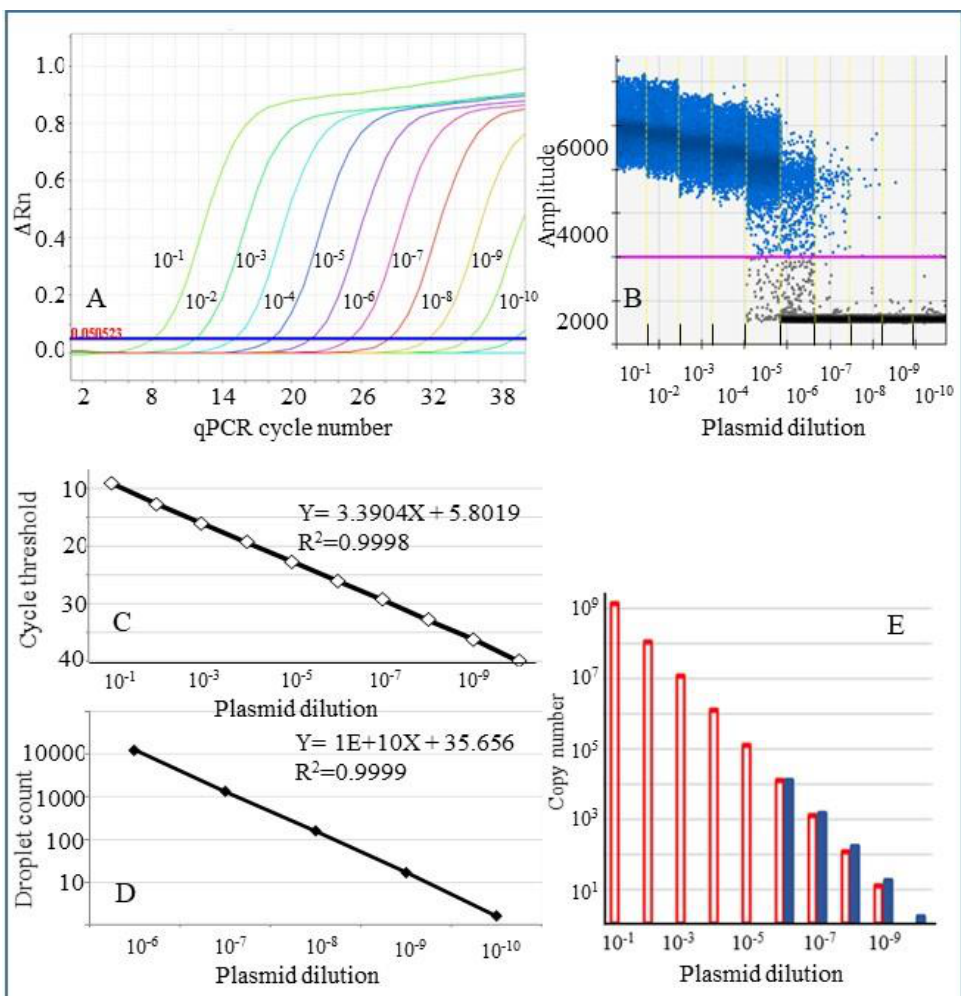
Figure 3. Linear regression analysis of qPCR and ddPCR conducted using ten-fold serial dilutions of a plasmid preparation containing CLas 16S rDNA fragment. ( A ). Amplification plots of plasmid serial dilutions in qPCR. ΔRn is the normalized reporter value (Rn) minus the Rn value of the baseline signal. Cycle threshold values are indicated on X-axis. The plasmid dilutions are shown to the left of each amplification graph. ( B ). ddPCR results of the plasmid dilutions used in qPCR. About 14,000 – 16,000 droplets passed QC in each assay. A manually determined cut-off line separated the distribution of negative and positive droplets shown. In the five lower dilutions (10 −1 to 10 −5 ), the droplets appear completely saturated (no negative droplets), and hence these are not ideal for quantification. ( C , D ). Linear regression line calculated based on the data points is indicated for qPCR ( C ) and ddPCR ( D ). ( E ). Copy numbers for qPCR (open, red bars) and digital PCR (solid, blue bars) calculated as described in materials and methods.